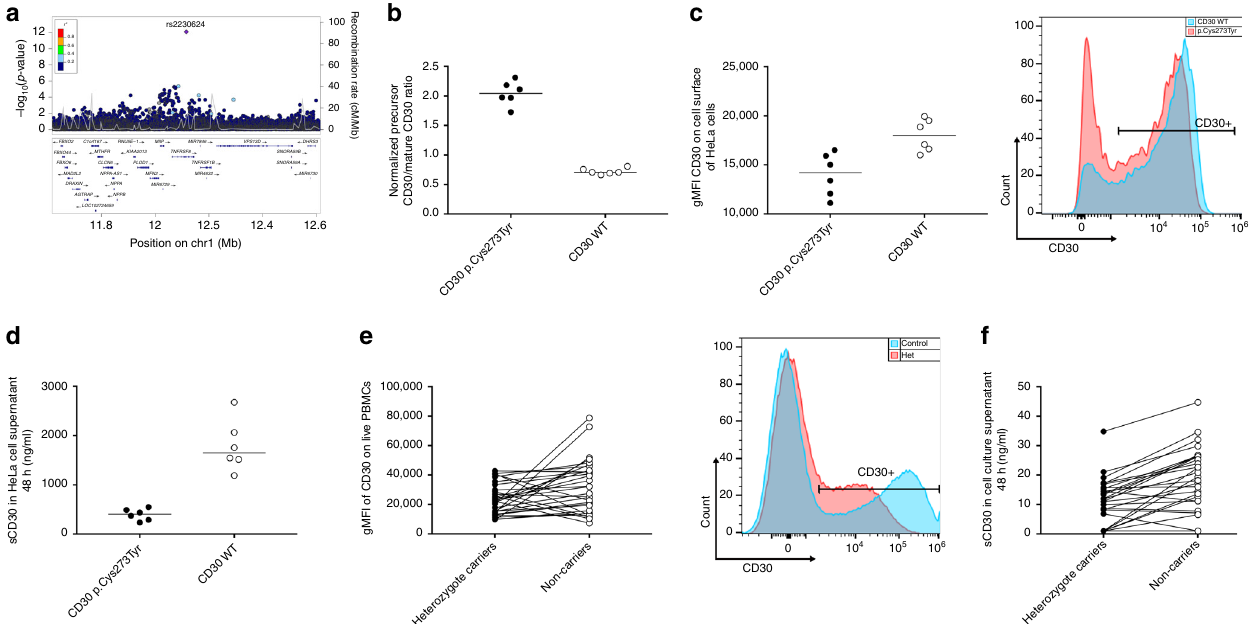
Fig. 2 Variant associating with reduced asthma risk affects protein expression and shedding of CD30. a Locus plots showing association with asthma where the lead variant p.Cys273Tyr (rs2230624) is colored in purple. Other variants are colored by degree of correlation ( r 2 ) with the lead variant. b Protein simple WES analysis of CD30 expression in cell lysates from HeLa cells overexpressing CD30 wild-type or variant p.Cys273Tyr CD30; graph showing ratio of CD30 precursor/mature intensity. c Surface expression of CD30 on HeLa cells over-expressing wild-type or p.Cys273Tyr CD30 measured by fl ow cytometry, displayed as geometric mean of fl uorescense intensity (gMFI). Histogram showing a representative CD30 surface expression p. Cys273Tyr (red) and CD30 WT (blue). d sCD30 levels (ng/ml) in cell culture supernatant from HeLa cells over-expressing wild-type or